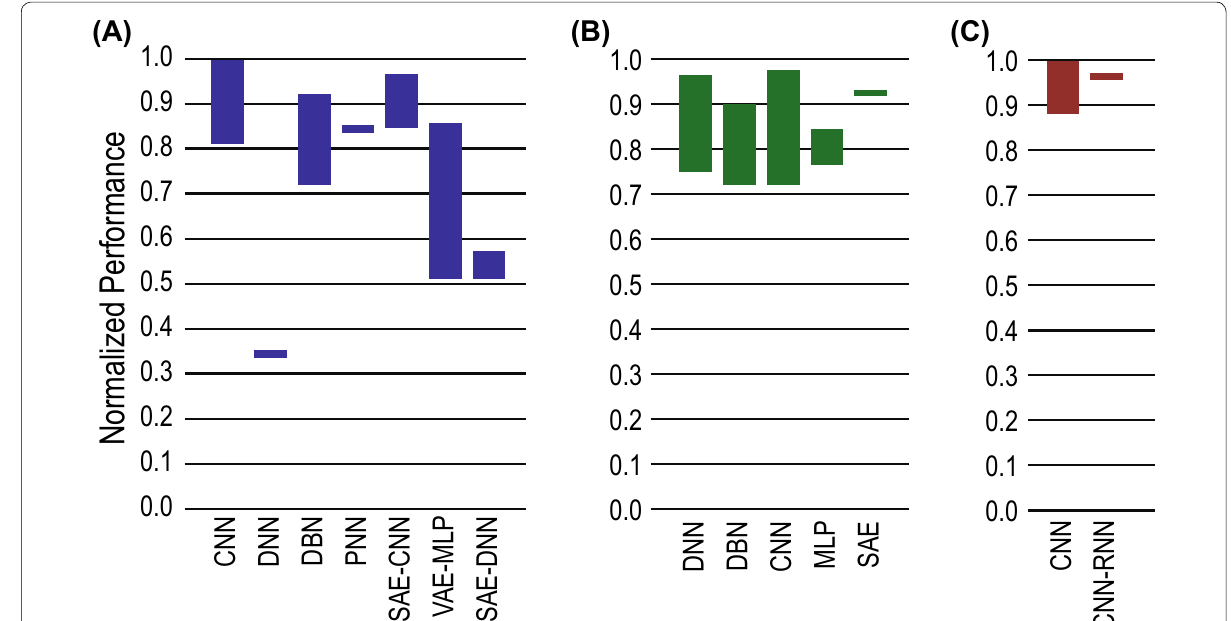
Fig. 4 Performance comparison of application of various DLs in detecting neurological disorders from MRI datasets. The normalized performance for a Alzheimer’s disease, b schizophrenia and c Parkinson’s disease detection shows which method works well on which type of disease. The height of the bars denote the range of performance values reported in the literature